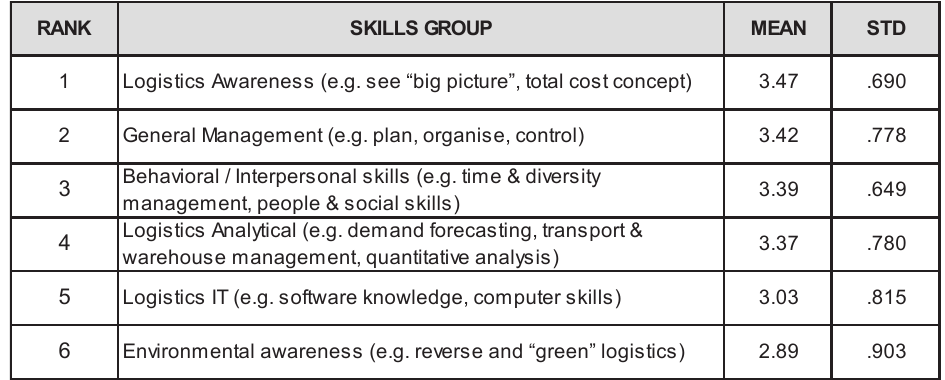
Figure 2: Respondents’ position in organisation Table 2: Mean rating of proposed skills groups Table 2: Mean rating of proposed skills groups